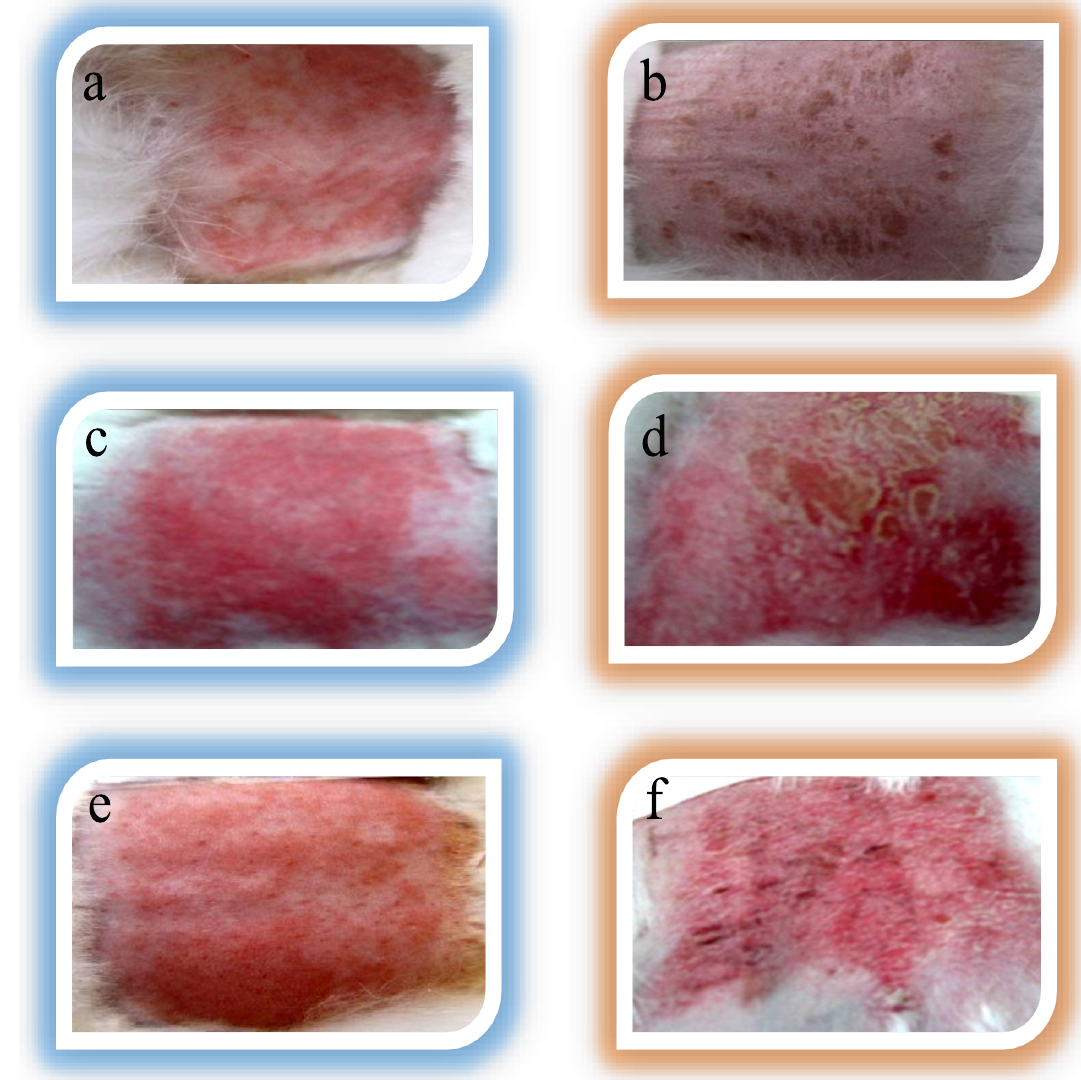
Fig. 3 . Skin reactions to AgNP samples in short term (1-4hours) and long term (>24 days ) dermal exposure. a) A-AgNP after short term dermal exposure. b) A-AgNP after long term dermal exposure. c) B-AgNP after short term dermal exposure. d) B-AgNP after short term dermal exposure. e) C-AgNP after short term dermal exposure. f) C-AgNP after long term dermal